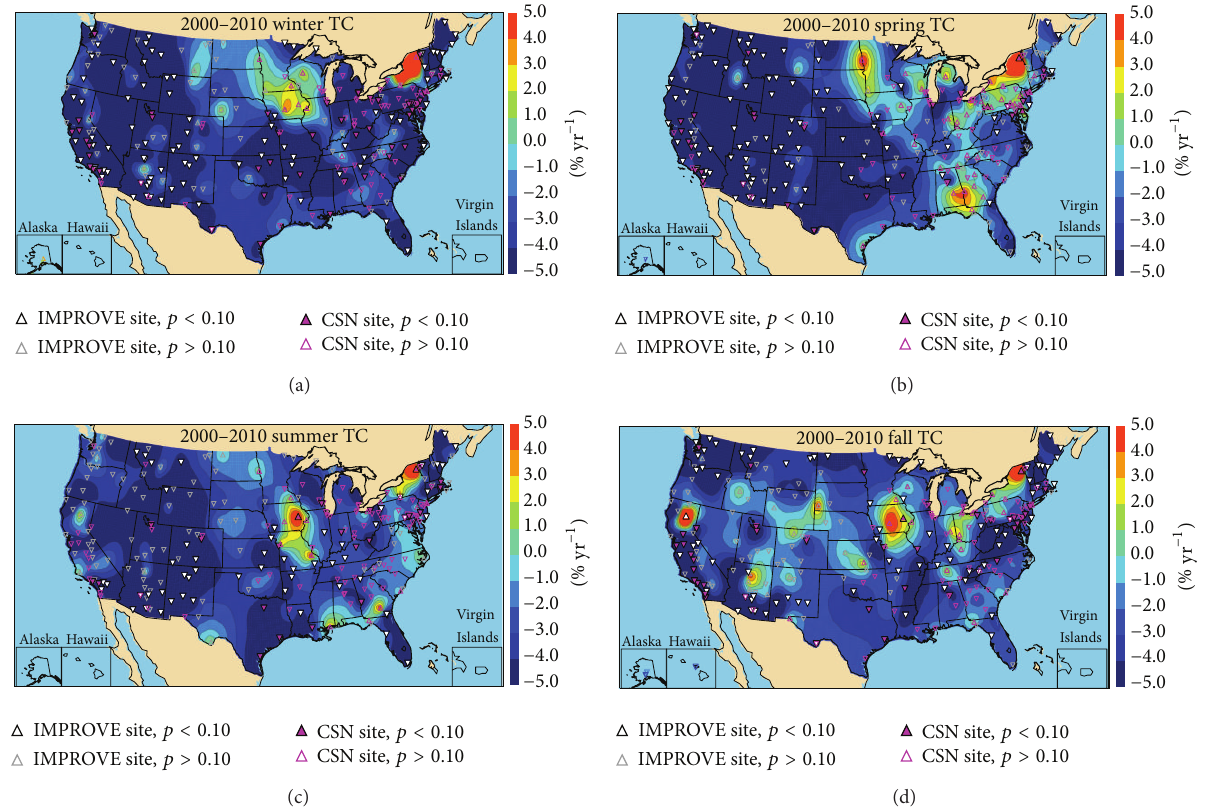
Figure 9: Short-term (2000–2010) trends (% yr −1 ) in IMPROVE and CSN seasonal mean PM 2.5 total carbon (TC = OC + EC) for (a) winter (DJF), (b) spring (MAM), (c) summer (JJA), and (d) fall (SON). White and magenta triangles correspond to IMPROVE and CSN sites, respectively. Upward pointing triangles correspond to increased concentrations and vice versa. Trends with significance levels ( 𝑝 ) less than 0.10 were considered significant. (filled triangles). Unfilled triangles correspond to insignificant